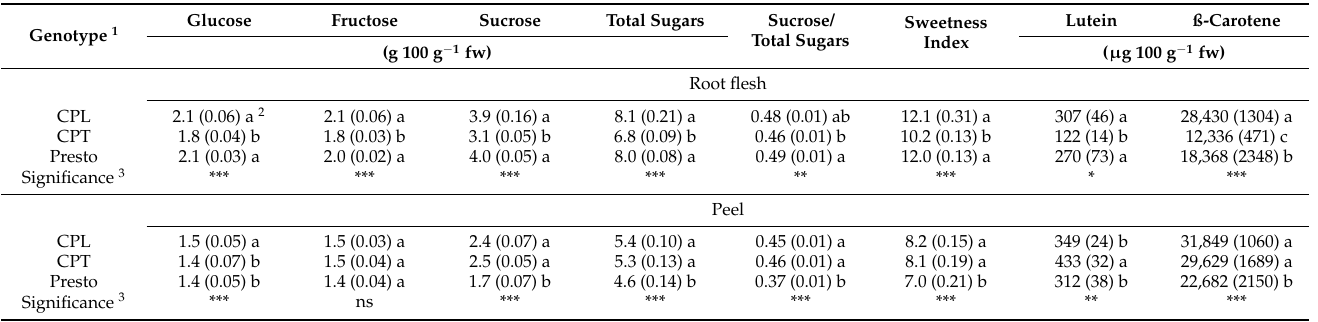
Table 4. Concentration of simple carbohydrates and carotenoids in the root flesh and peel of carrot